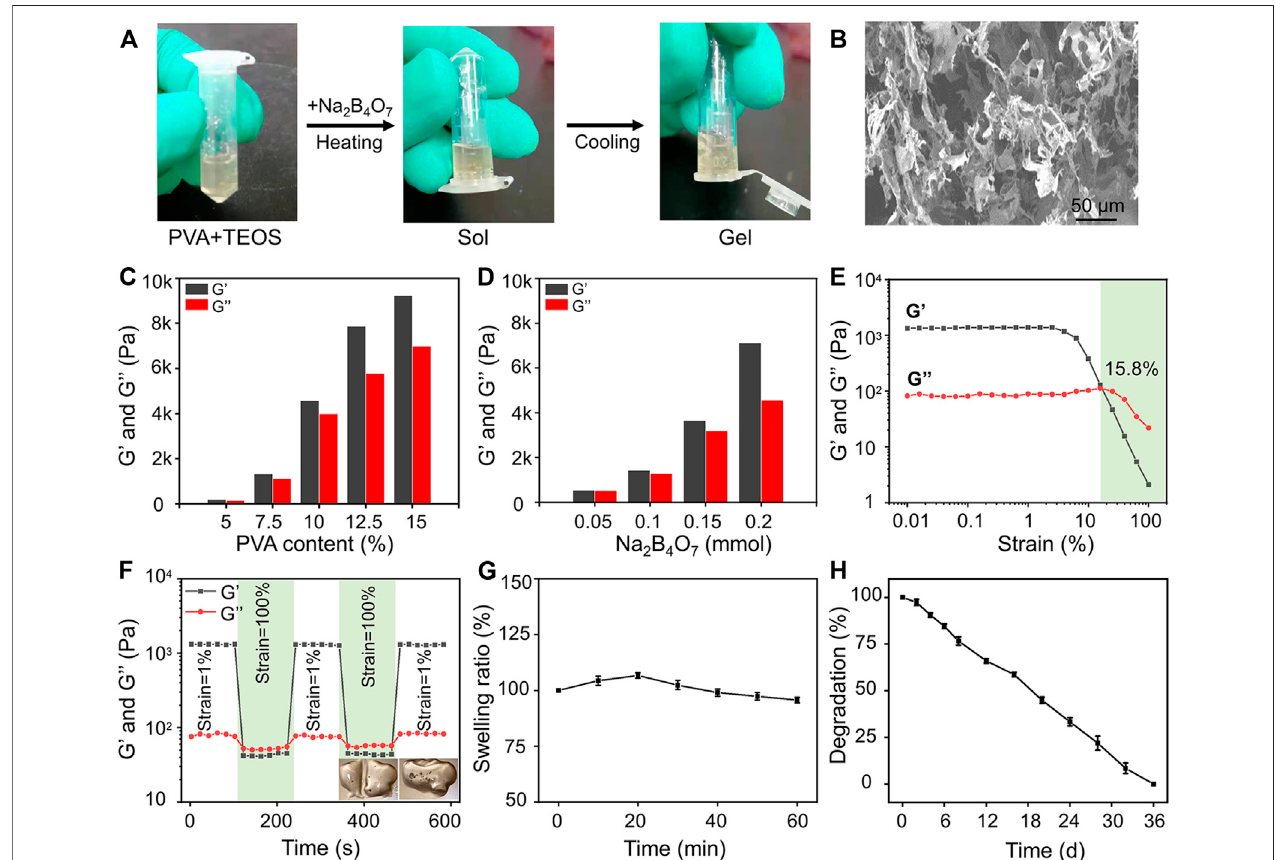
FIGURE 1 | Preparation and characterization of hydrogels. (A) Photographs of the gelation progress. The mixture of the prepared PVA and TEOS solution was presentedinthesolstate,anditexperiencedsol – geltransitionafteraddingNa 2 B 4 O 7 solution. (B) SEMobservationofpreparedhydrogels. (C) Storagemodulusandloss modulus of prepared hydrogels as the concentration of PVA increased from 5 to 15 wt%. (D) Storage modulus and loss modulus of prepared hydrogels as the concentrationofNa 2 B 4 O 7 increasedfrom0.05to0.20 mmol. (E) Strainamplitudesweepofthehydrogel. (F) Stepstrainmeasurementsofthehydrogelwitha fi xed frequency of 1 rad/s, and the macroscopic observation of self-healing property. (G) Equilibrium swelling ratio. (H) In vitro degradation (the tested hydrogel formula